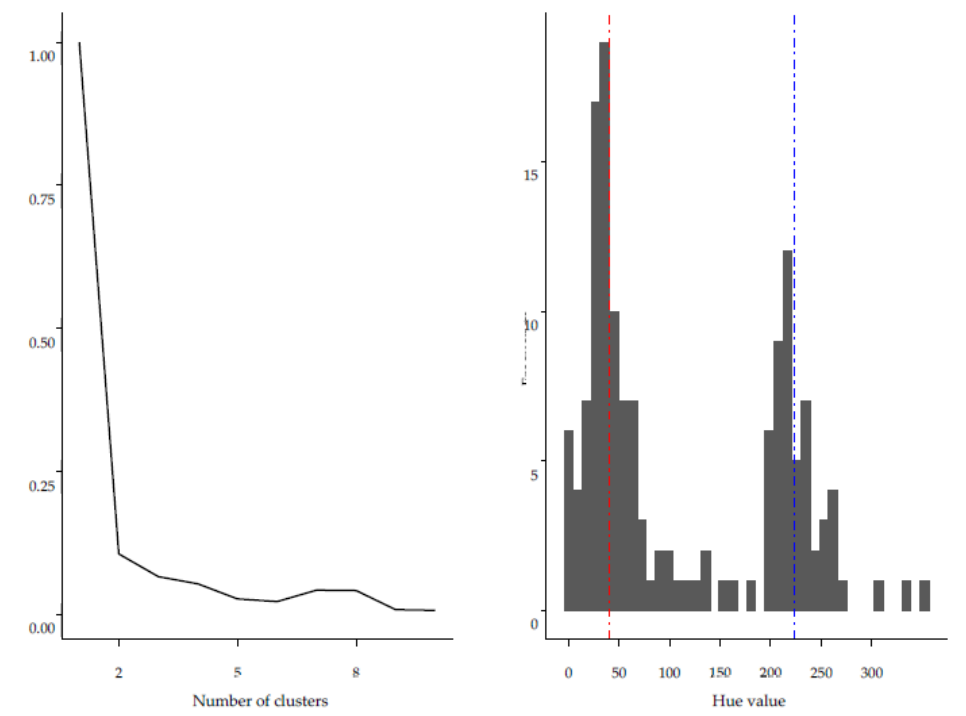
Figure A1. ( Left ): Elbow plot showing how the within cluster sum of squares varies as the number of clusters increase, when clustering the images based on their dominant hue values. As the plot indicates, two clusters seem to be the optimal choice. ( Right ): Histogram of the dominant hue values detected in the images (note: only those not containing any text were analysed in this scenario). As the visual inspection suggests, we observe two clusters centred on the red and blue tones of hue.